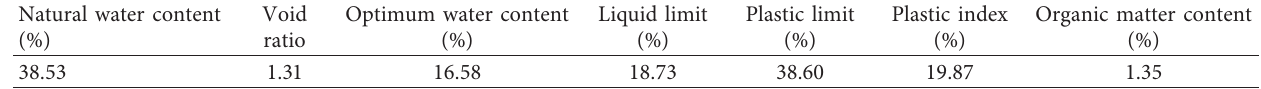
Table 1: Basic physical properties of excavated soil.